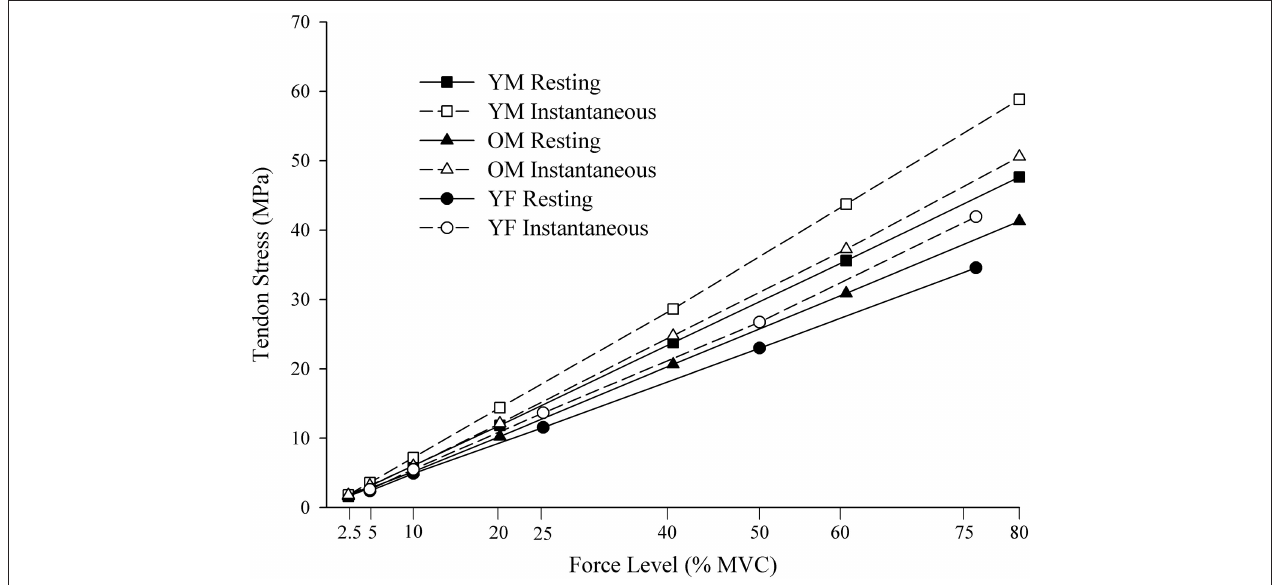
FIGURE 5 | Stress values calculated using the resting and instantaneous tendon CSA. CSA, cross-sectional area YM, young males; OM, old males; YF, young females. MPa, megapascals; MVC, maximal voluntary contraction.